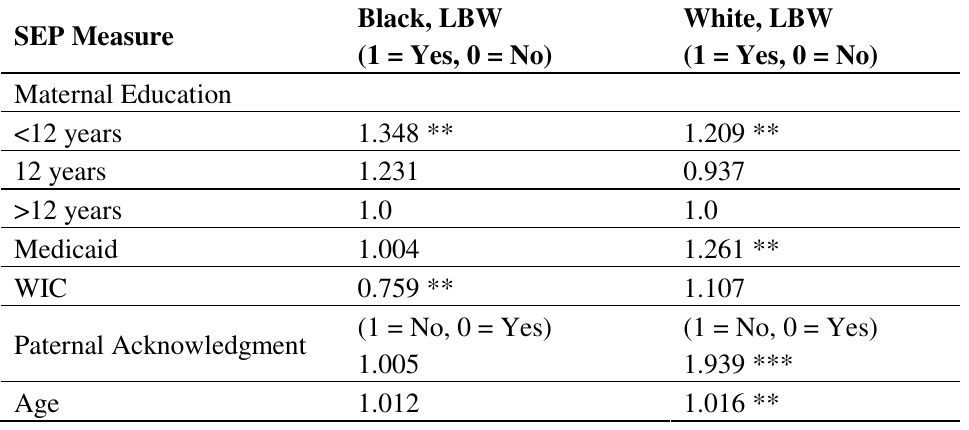
Table 4. Odds ratios for SEP measures and LBW for blacks and whites (stratified